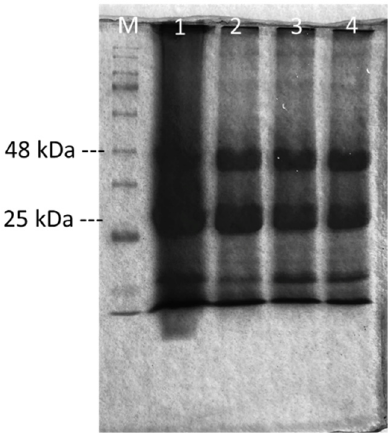
Figure 1. SDS–PAGE gel image of extracellular proteins produced by B. halodurans . Lane M is the marker (PageRuler prestained protein ladder), lane 1 is the extracellular protein induced by the combination of xylan and xylo-oligosaccharides, and lanes 2 and 4 are those induced by xylo-oligosaccharides. Table 2. Concentration and activity of extracellular proteins induced by B. halodurans with xylan and xylo-oligosaccharides (DP2 and